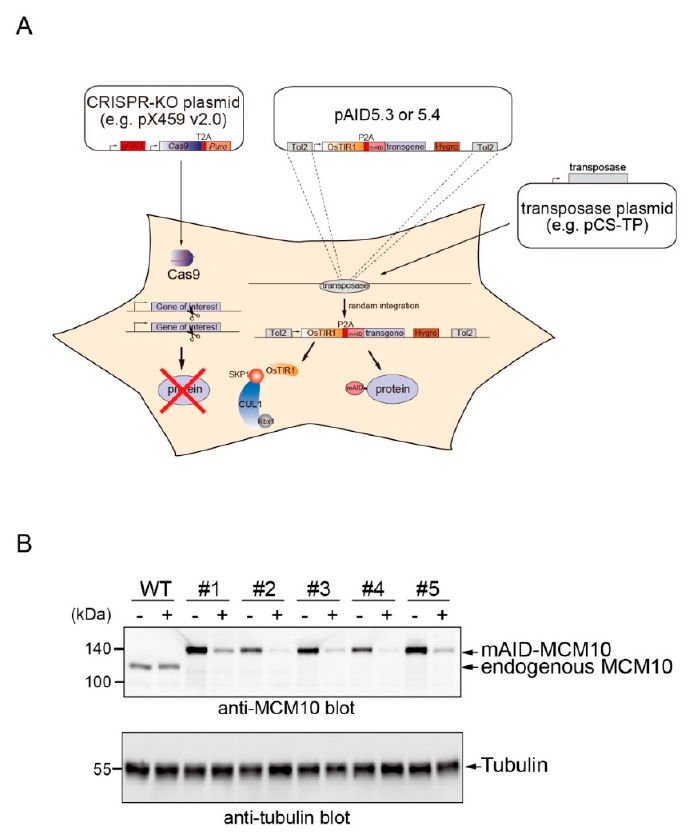
Figure 3. Generation of MCM10 mutant cell lines on a HeLa background. ( A ) Schematic showing the strategy used to construct an AID mutant using CRISPR-KO and bicistronic pAID5 plasmids. The CRISPR-KO plasmid expresses a Cas9–gRNA complex for gene knockout. The bicistronic rescue plasmid is integrated into the genome by the action of TOL2 transposase and expresses both OsTIR1 and mAID-fused protein. ( B ) Immunoblot showing endogenous MCM10 and mAID–MCM10. HeLa clones were treated with 500 µ M IAA for 2 h and protein extracts were separated by SDS-PAGE. Tubulin is a loading control.